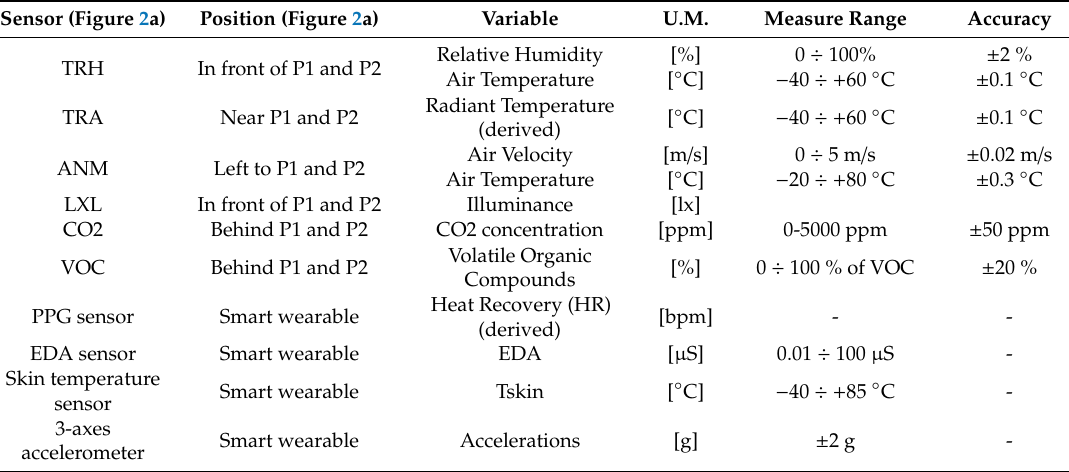
Table 2. Characteristics of sensors installed in the test cell.